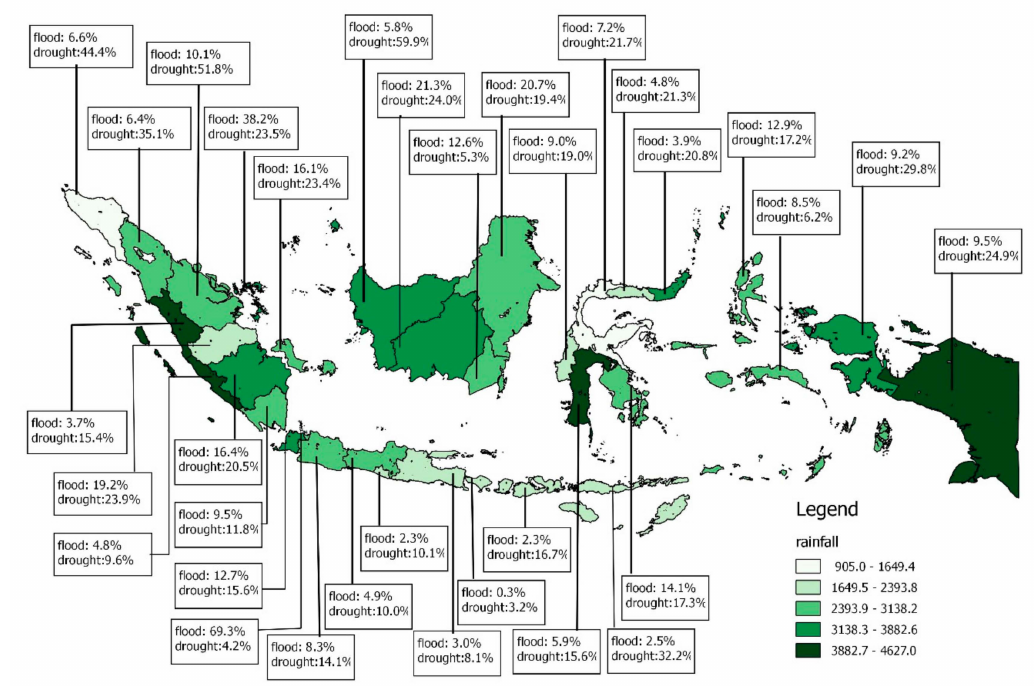
Figure 6. The distribution of farmers experiencing flood and drought in each province of Indonesia (the rainfall intensity unit is mm /